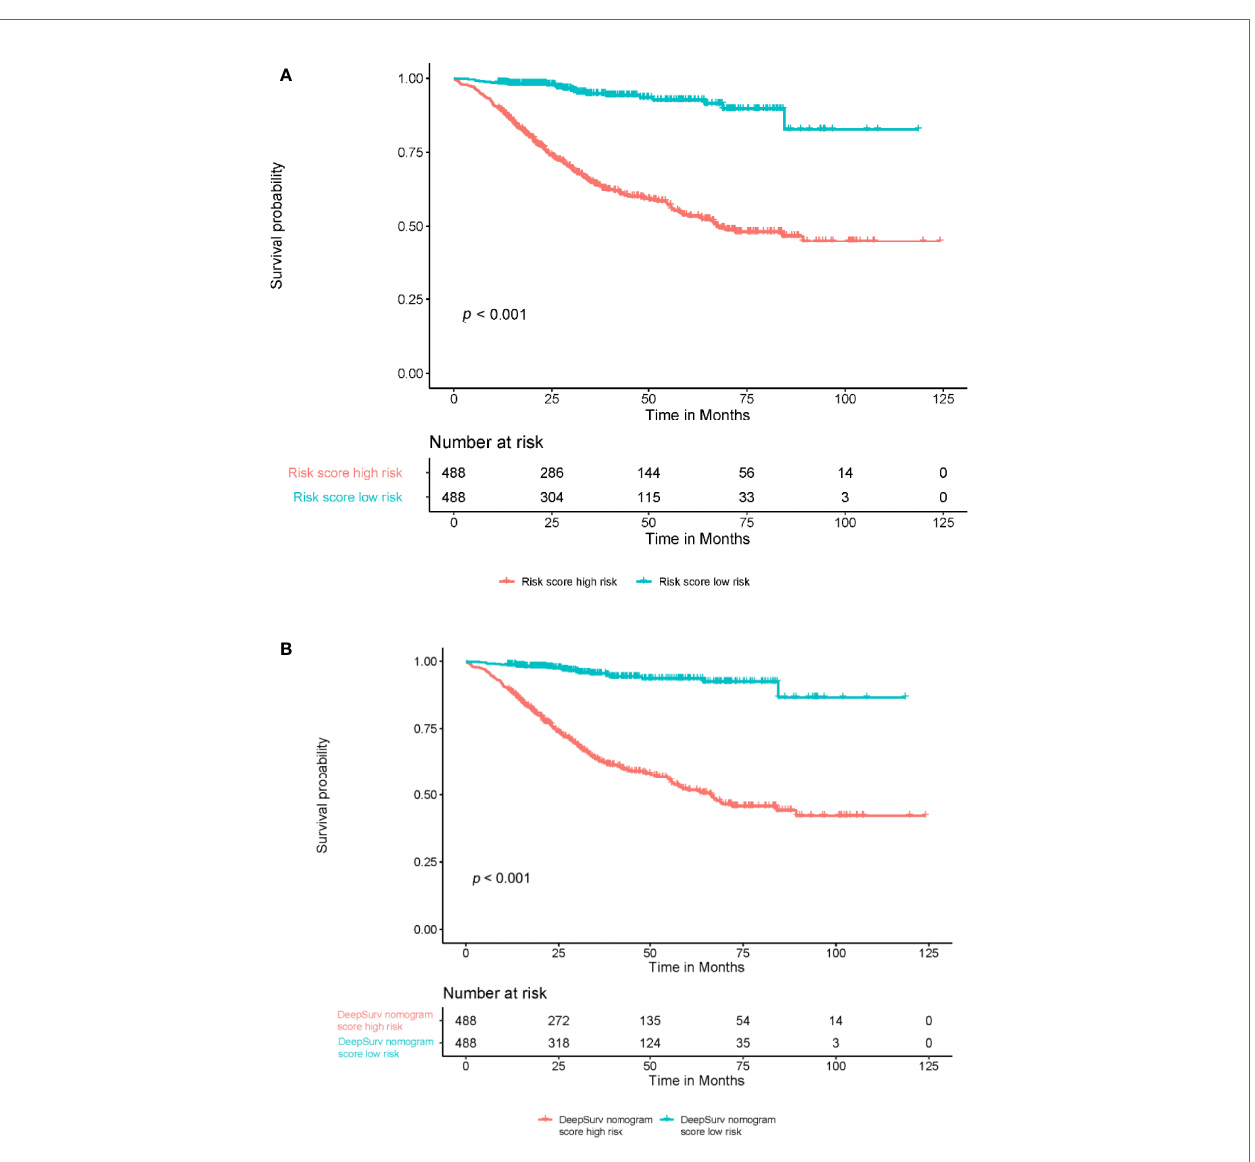
FIGURE 6 | Predictive capacity of the risk score and the DeepSurv nomogram score. The Kaplan-Meier curve shows that both the risk score and DeepSurv nomogram score could effectively discriminate between patients with better and worse survival (A, B) ( P <0.001, log-rank